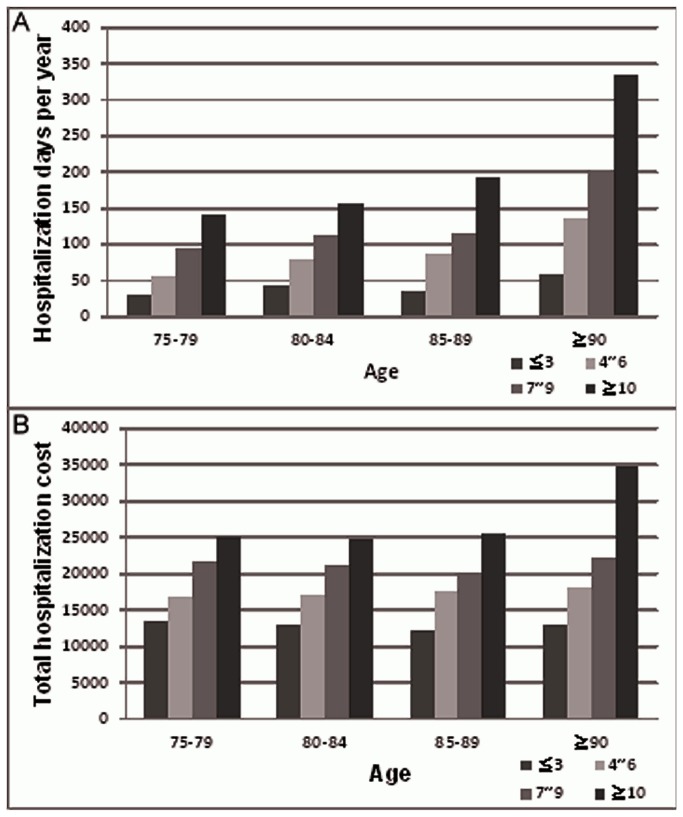
Hospitalization days per year and total hospitalization cost stratified by age and Charlson comorbidity index in elderly hemodialysis patients.(A) Increased duration of hospital stay for patients in the same age group with increased CCI levels (B) Increased mean admission costs (US dollars) for patients in the same age group with increased CCI levels (one United States dollars = 32.59 New Taiwan dollars).